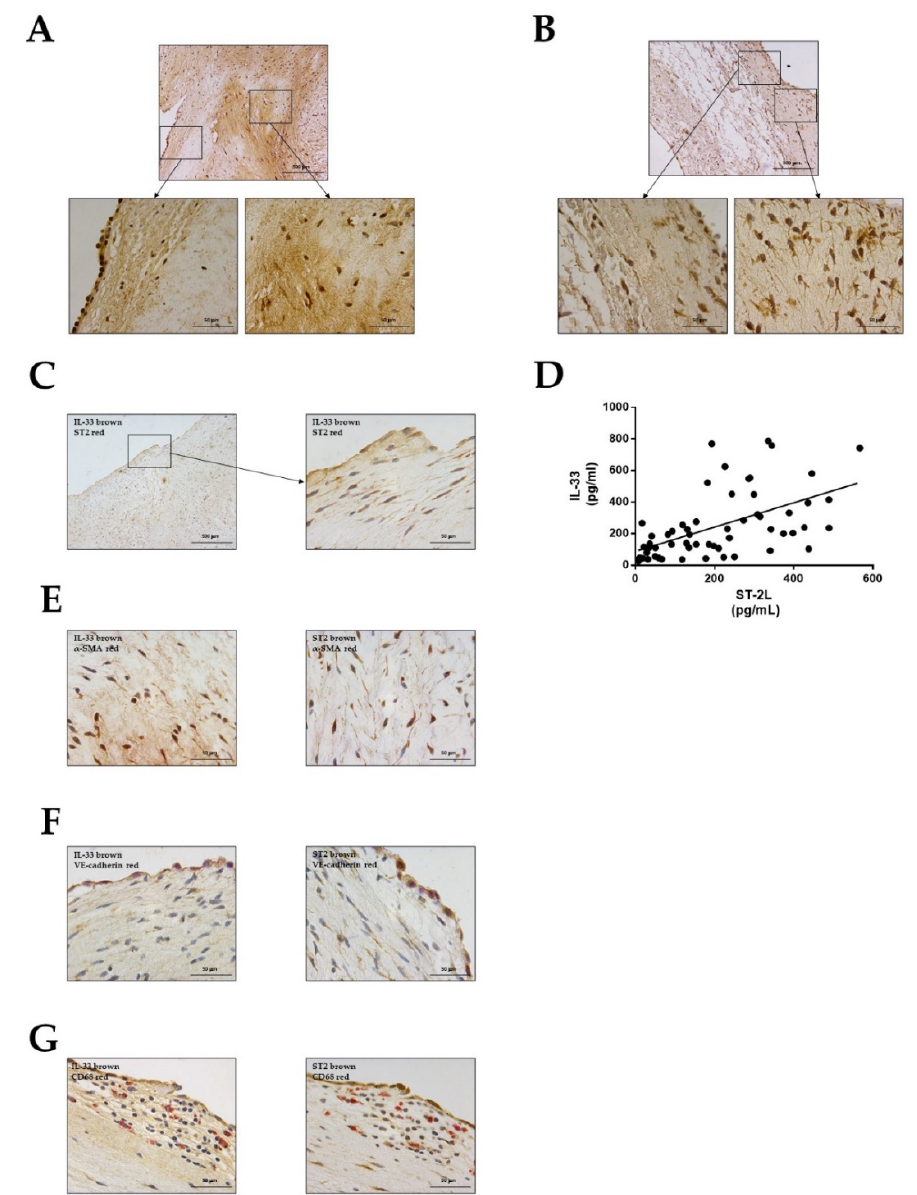
Figure 1. IL-33 and ST2 expression in myxomatous mitral valves. Representative microphotographs at low and high magnification of human myxomatous mitral valve sections stained for IL-33 ( A ), ST-2 ( B ) and double immunohistochemistry for IL-33 (brown) and ST-2 (red) ( C ). Correlation between IL-33 and ST-2 ( r = 0.548, p < 0.0001) protein levels in human myxomatous mitral valves ( D ). Representative microphotographs of immunohistochemistry double staining for IL-33 (brown) and α -SMA (red) on the left and ST2 (brown) and α -SMA (red) on the right ( E ), IL-33 (brown) and VE-cadherin (red) (left) and ST2 (brown) and VE-cadherin (red) (right) ( F ) and IL-33 (brown) and CD68 (red) (left) and ST2 (brown) and CD68 (red) (right) ( G ). Magnification 50 × (Scale bar 500 µ m) and 400 × (Scale bar 50 µ m). Protein data in pg/mL. IL-33: Interleukin-33; α -SMA: Alpha-smooth muscle actin.